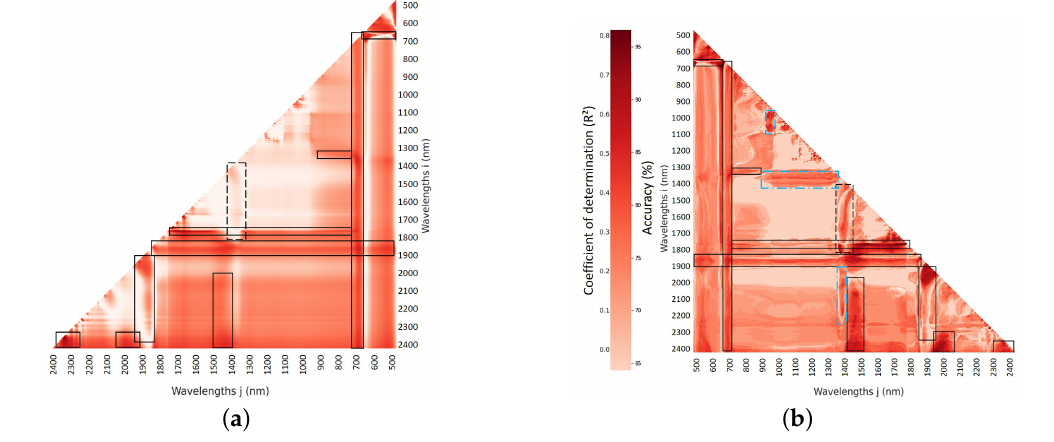
Figure 22. Correlation matrix showing coefficient of determination and accuracy between NDSI by wavelengths and SWP values or classes for plots A and C. Same significant domains are high- lighted with a black line. One domain is more significant with classification than with regression; it is surrounded with a black dotted line. Three domains that are not present with regression are surrounded with a blue dotted line on the classification correlation matrix. ( a ) Regression method. ( b ) Classification